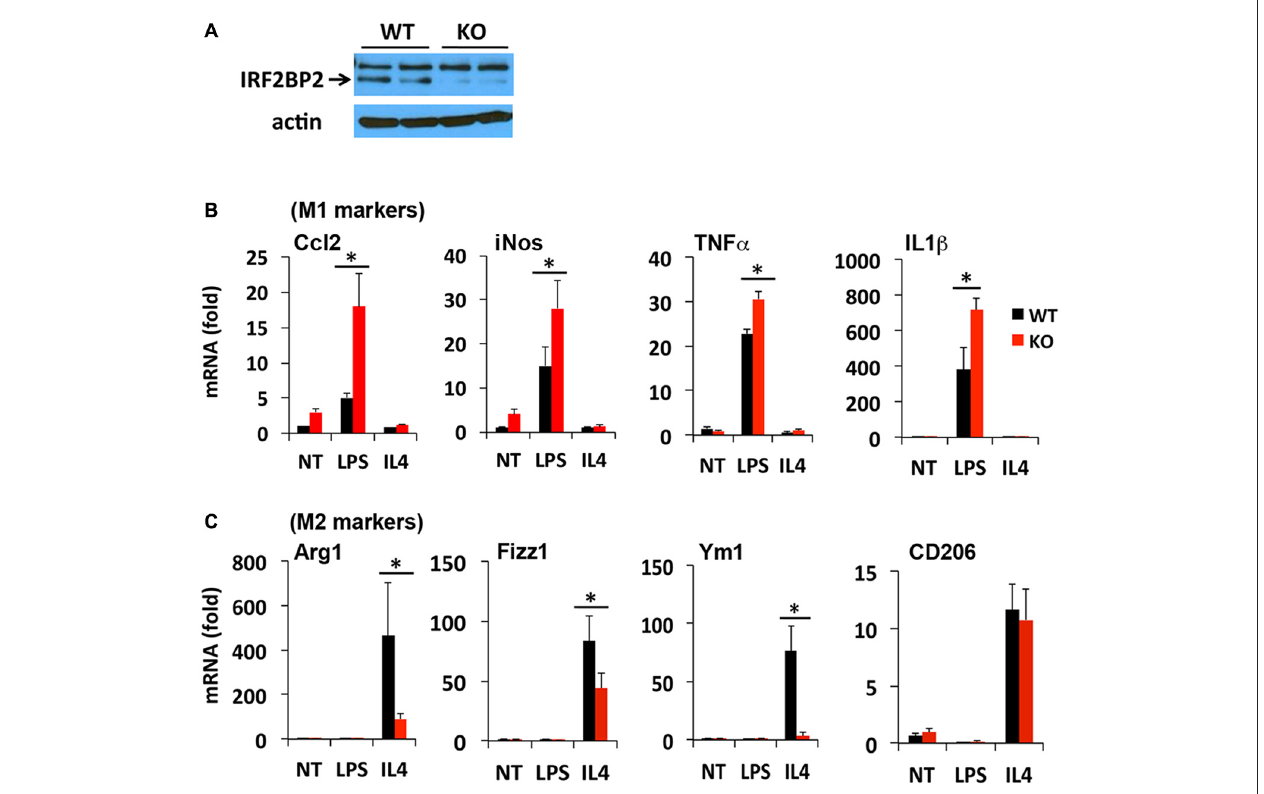
FIGURE 1 | Ablation of IRF2 binding protein 2 (IRF2BP2) skews microglia activation towards an inflammatory phenotype. (A) Immunoblot shows loss of IRF2BP2 protein in microglia from LysMCre/IRF2BP2flox (KO) mice. WT, littermate controls. IRF2BP2-deficient microglia have markedly increased expression of (M1) inflammatory markers inducible nitric oxide synthase (iNOS), Ccl2, and the cytokines Tumor Necrosis Factor- α (TNF α ) and IL1 β after lipopolysaccharide (LPS) challenge (B) but a reduced response of anti-inflammatory (M2) markers Arginase 1 (Arg1), Fizz1, Ym1 to interleukin-4 (IL4) stimulation (C) . NT, non-treated. N = 3 mice/group. ∗ p <